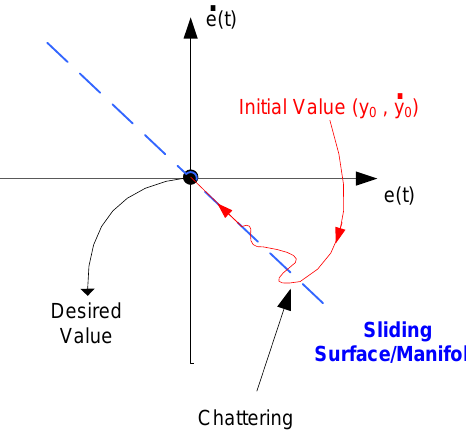
Figure 13. Working operation of SMC [141].